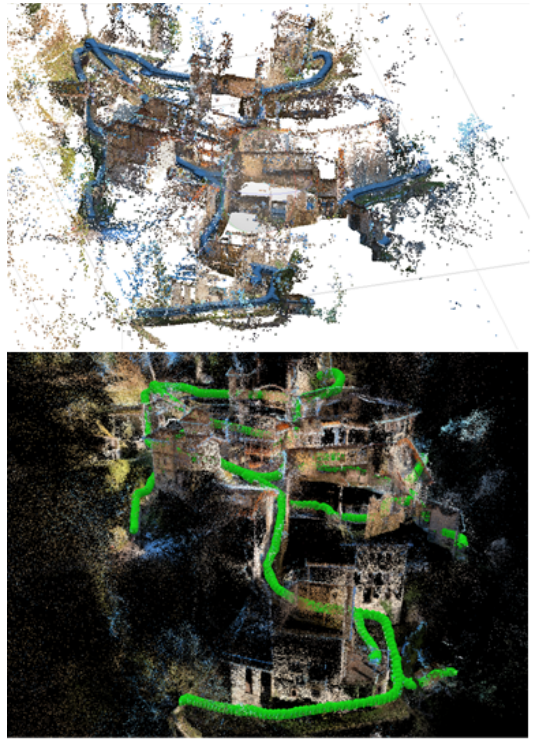
Figure 12: Orientation results obtained with Agisott Metashape (top) and Pix4Dmapper (bottom).